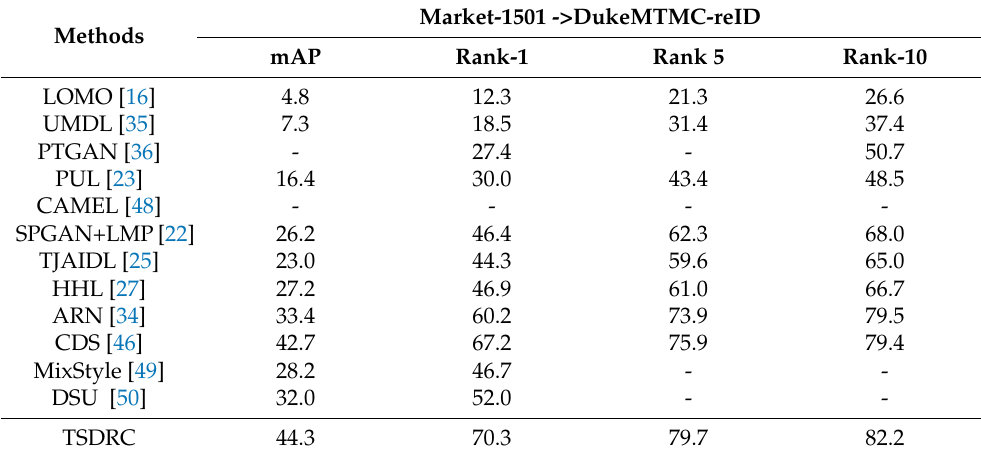
Table 4. Comparing TSDRC with other unsupervised domain-adaptive person ReID approaches on Market-1501 and DukeMTMC-reID datasets.